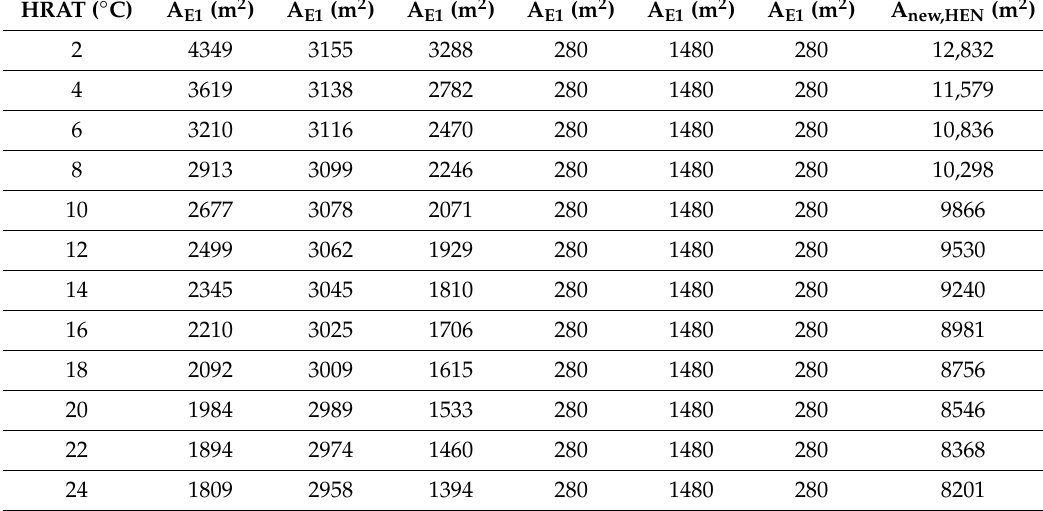
Table A11. Heat transfer area for HEN exchangers after heat-shifting, using option 1. HRAT ( ◦